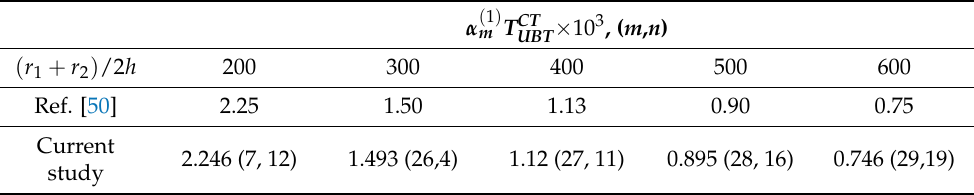
with the results of Ref. [50]. UBT